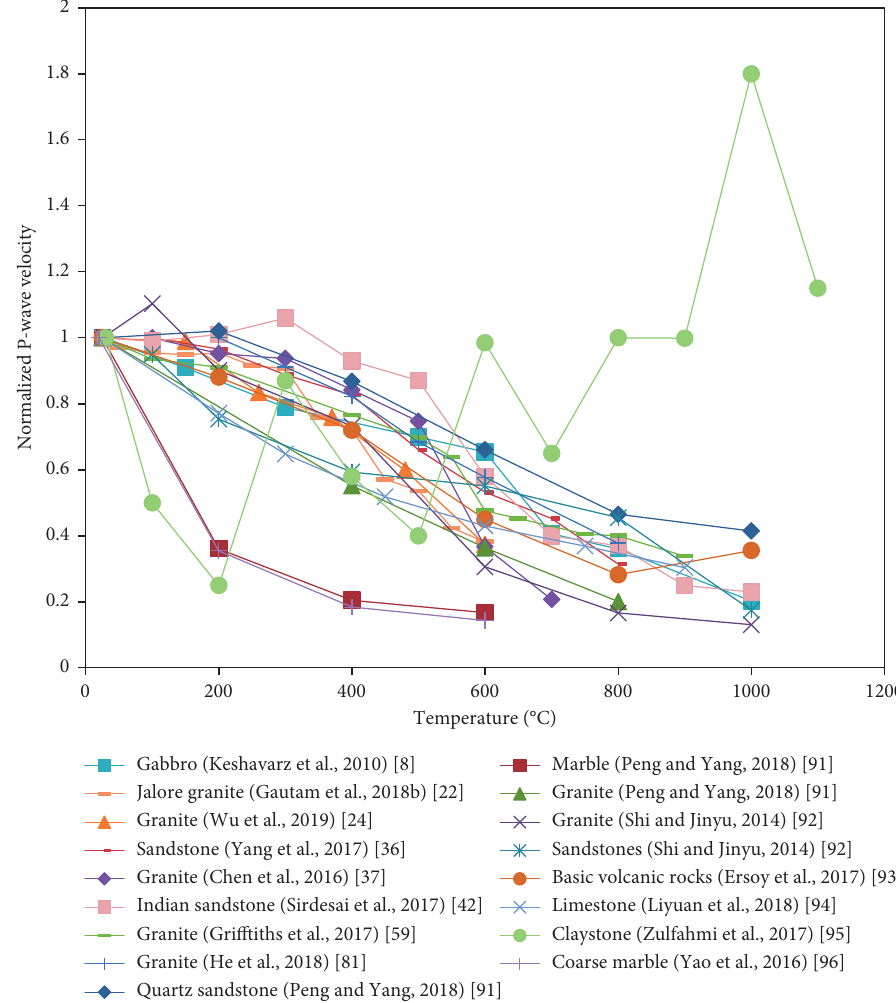
Figure 3: Change in normalized wave velocity V